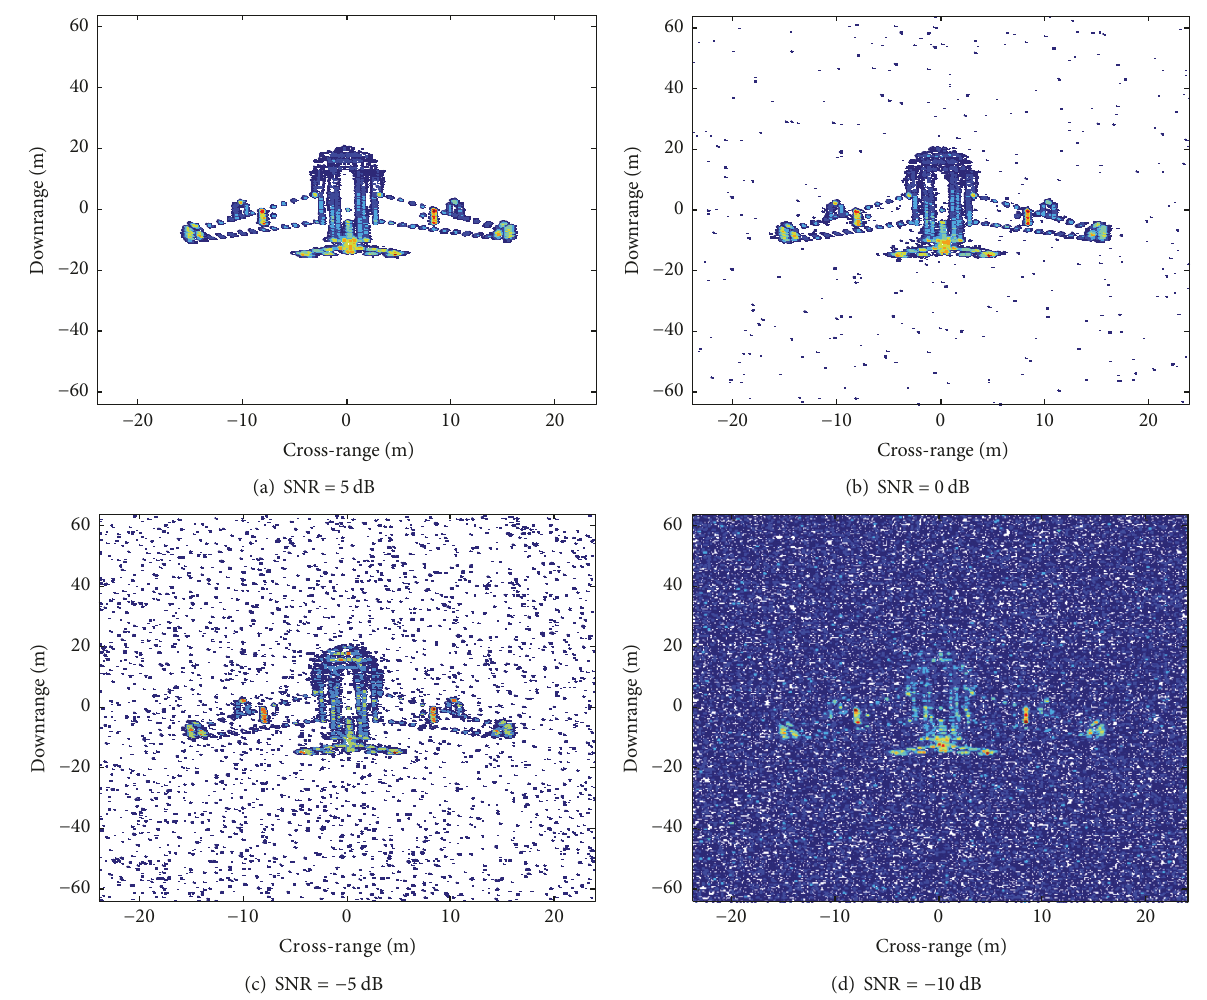
Figure 9: ISAR image formation of the Yak-42 plane model with various